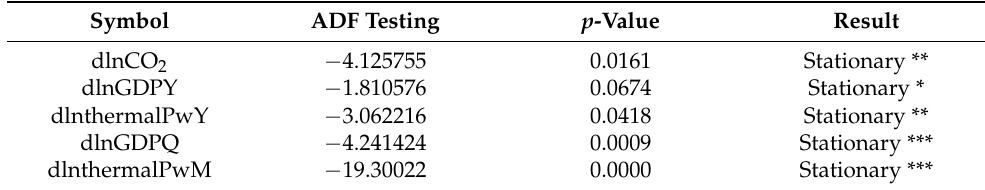
Table 3. Stationary test results.